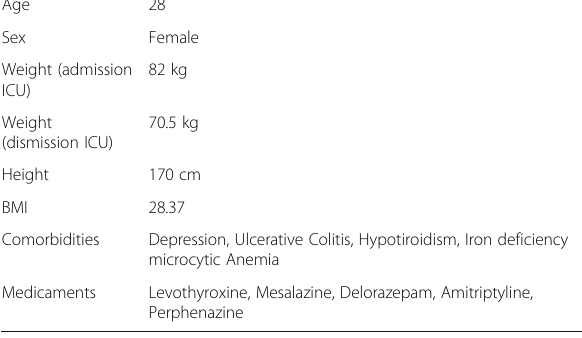
Fig. 1 (abstract A104). A AND B ) Admission abdomen ct scan showing retroperitoneal necrosis from mediastinum to PSOAS muscle and soft tissues gas gangrene in perianal area; C ) Gas gangrene in perianal area, mostly on the right side, before surgical toilette; D AND E ) Gas gangrene reduction and necrosis increase after surgical drainage